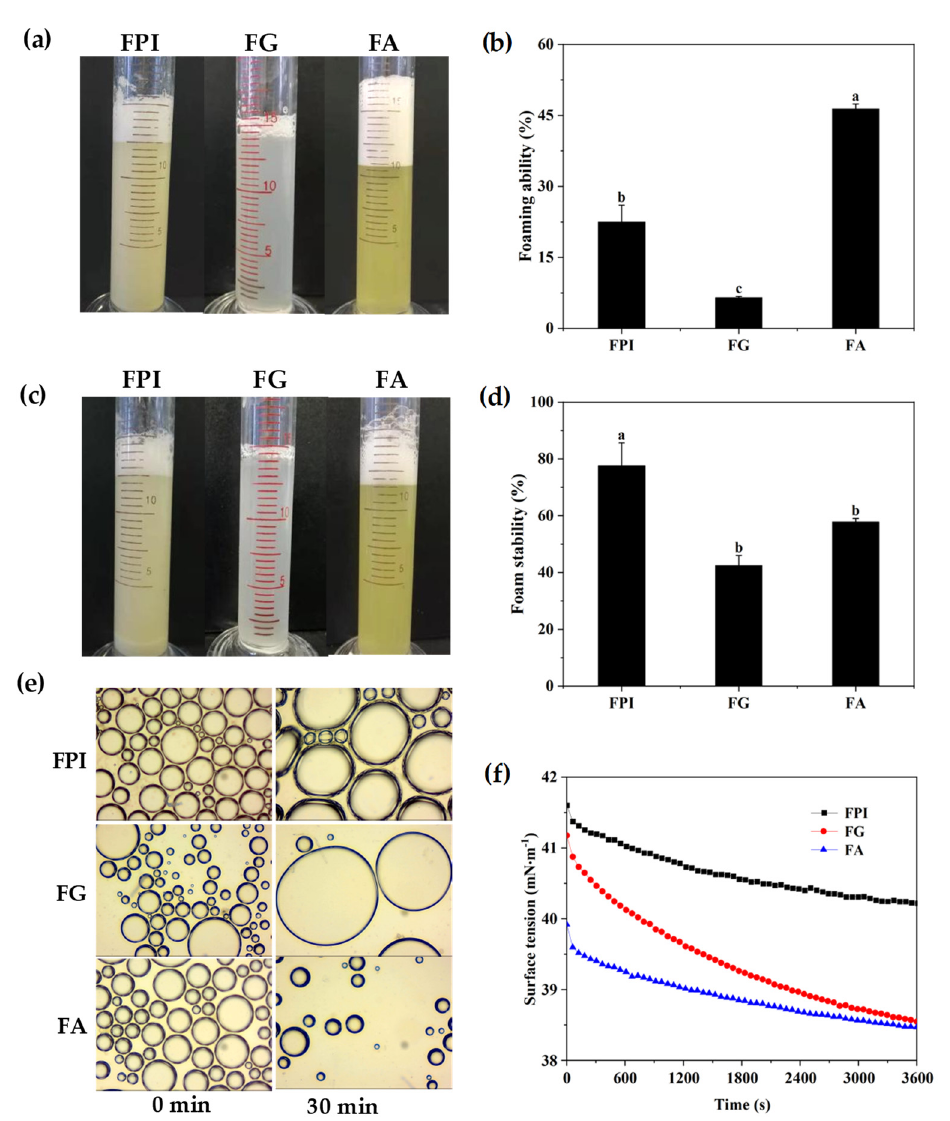
Figure 2. The foaming properties of FPI, FG, and FA. ( a , c ): photograph of foam formed by FPI, FG, and FA at 0 min and 30 min; ( b ): the foaming ability; ( d ): the foam stability; ( e ): the morphology of foams immediately after shearing and standing for 30 min; ( f ): the interfacial tension at air–water interface. Different alphabets in same index indicated significant differences at the p < 0.05 level. FPI: flaxseed protein isolate; FG: flaxseed globulin; FA: flaxseed albumin.